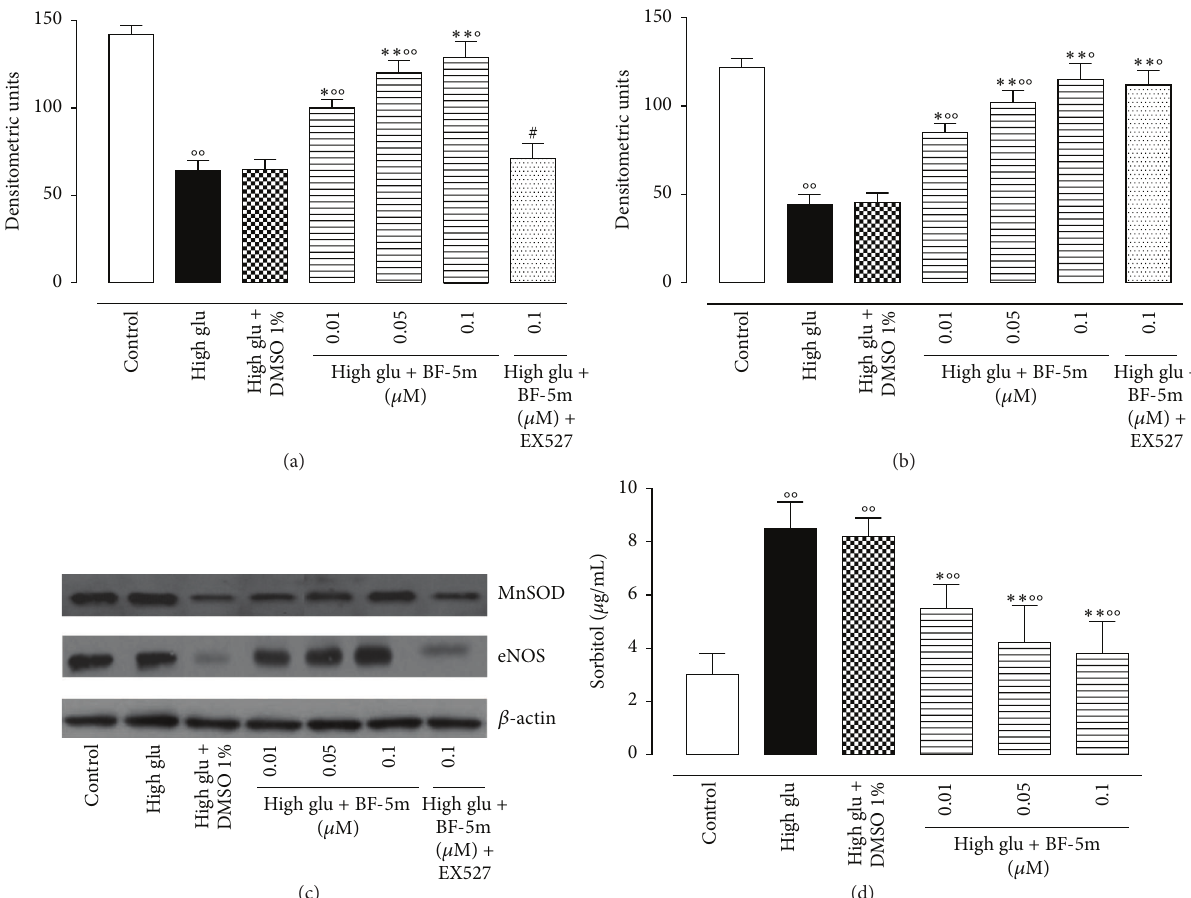
Figure 4: (a) MnSOD expression in hearts perfused with glucose 11.1mM (control); glucose 11.1mM + DMSO 1% (vehicle); glucose 33.3 mM (high glu); high glu + BF-5m (0.01, 0.05, and 0.1 𝜇 M); high glu + BF-5m (0.1 𝜇 M) + EX527 (10mg/kg/day i.p.). (b) eNOS expression levels in hearts perfused as in panel (a). Results are derived from western blotting (panel (c) representative) and expressed as densitometric units; (d) tissue sorbitol content ( 𝜇 g/mL). Mean ± s.e.m. of 𝑛 = 10 observations for each group. Significant differences versus control are reported as ∘ 𝑃 < 0.05 and ∘∘ 𝑃 < 0.01 ; significant differences versus high glu are reported as ∗ 𝑃 < 0.05 and ∗∗ 𝑃 < 0.01 ; significant differences versus high glu + BF-5m 0.1 𝜇 M are reported as # 𝑃 < 0.01 . 0100200300 #